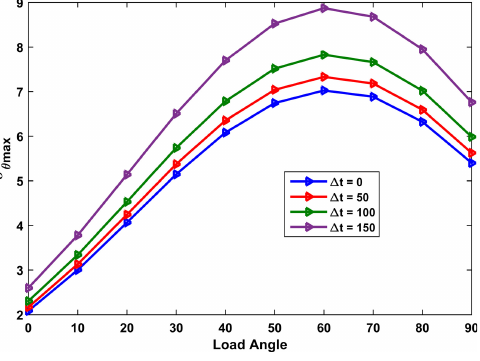
Figure 9: Effect of and load angle on σ θ max (a/b = 2, Load angle variation from 0 ∘ to 90 ∘ axis, [0 /90]s)